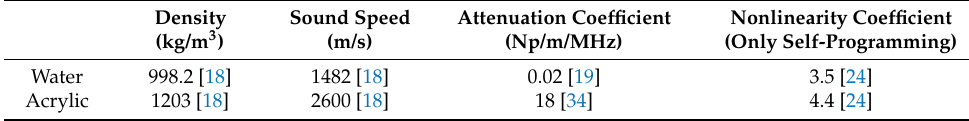
Figure 1. Schematic diagram of the numerical simulation model. Table 1. Simulation parameters table of water and acrylic plate.